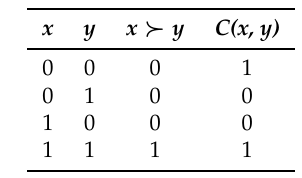
Table A1. Causation versus correlation: a logical